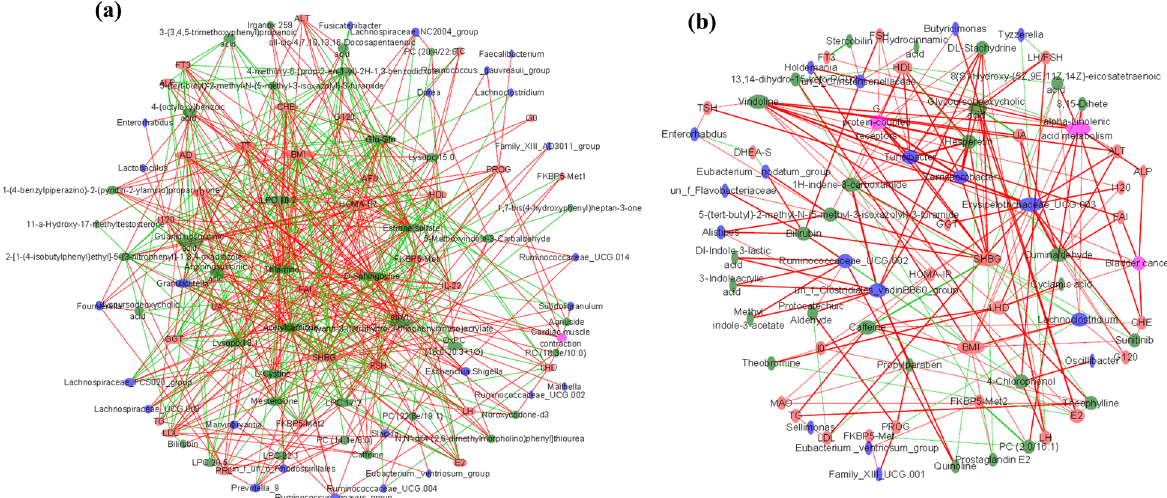
Fig. 6 Co-occurrence network. a Network characteristics screened from comparisons between healthy patients and patients with PCOS-HB. b Network characteristics screened from comparison between PCOS-HB and PCOS-LB groups. Green, blue, red, and pink ellipses denote metabolites, bacteria, clinical parameters, and predicted pathways, respectively. The red and green lines denote positive and negative correlations, respectively. The size of the ellipse denotes the correlation degree. Featured clinical parameters, stress indices DNA methylation, bacterial species, and predicted functional pathways were used. PCOS-LB, normal BMI (BMI < 24); PCOS-HB, high BMI (BMI ≥